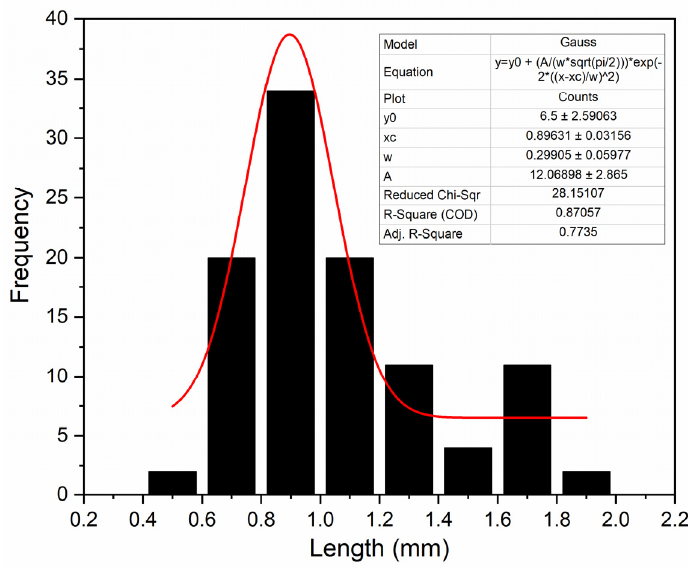
Figure 6. Statistical analysis of crystals without UV assistance. There is an average size of 0.9 mm in 32.2% of the crystals: Average size ( xc ) = 0.9 mm Peak width ( w ) = 0.29 mm